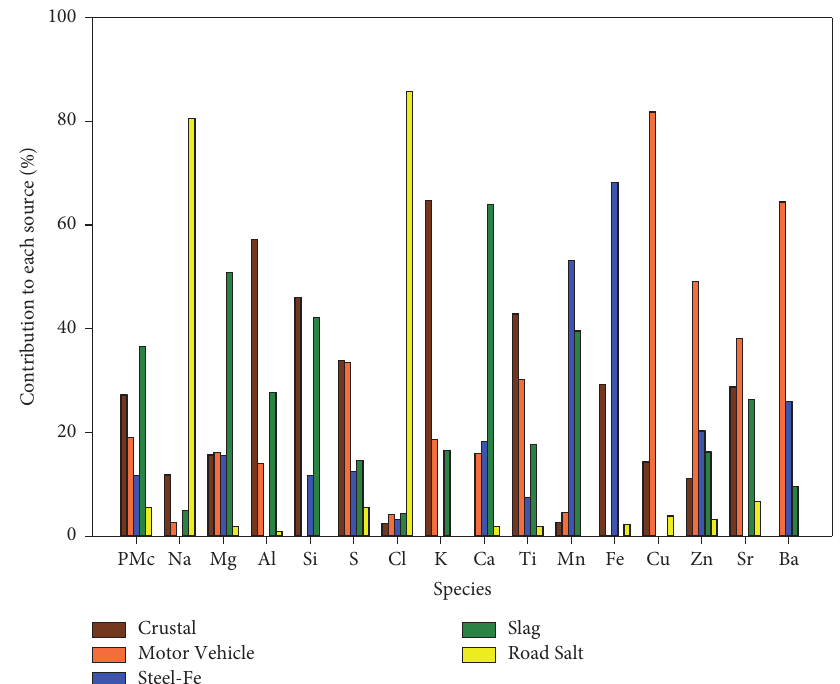
Figure 3: Coarse PM source